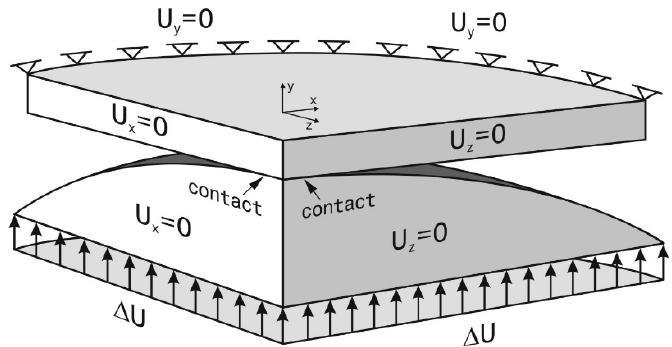
Figure 5. Displacement boundary conditions of the FEM model.